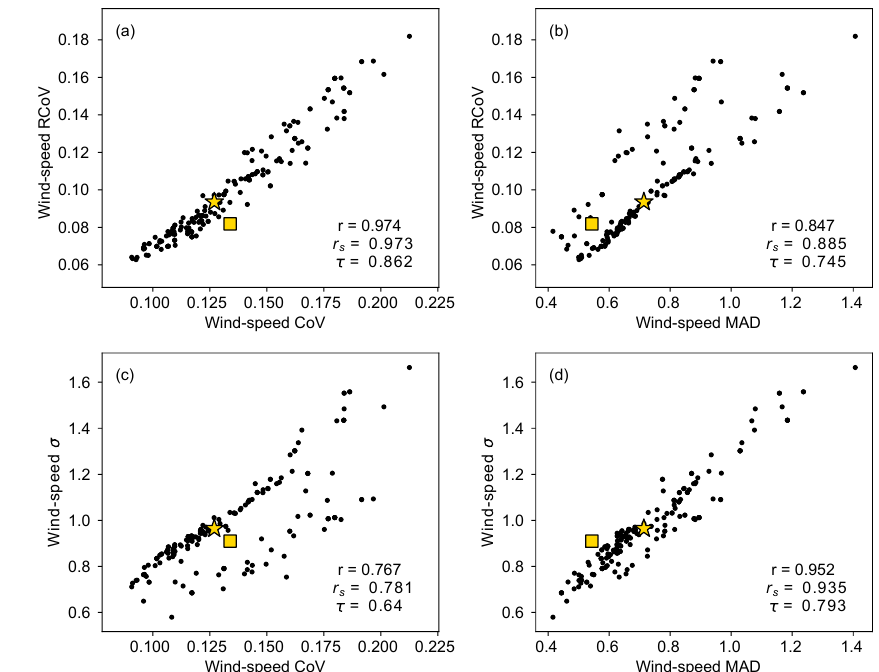
Figure 6. Similar to Fig. 4, but for scatterplots to compare 37-year wind-speed variability metrics: (a) RCoV and CoV, (b) RCoV and MAD, (c) σ and CoV, and (d) σ and MAD, based on monthly data from the 195 r -filtered wind sites. Each black dot represents each filtered site, and the r , r s , and τ at the corner of each panel indicate the Pearson’s r , the Spearman’s rank correlation coefficient, and the Kendall’s rank correlation coefficient between each pair of wind-speed spread metrics. The yellow square and the yellow star denote the OR and the TX sites,